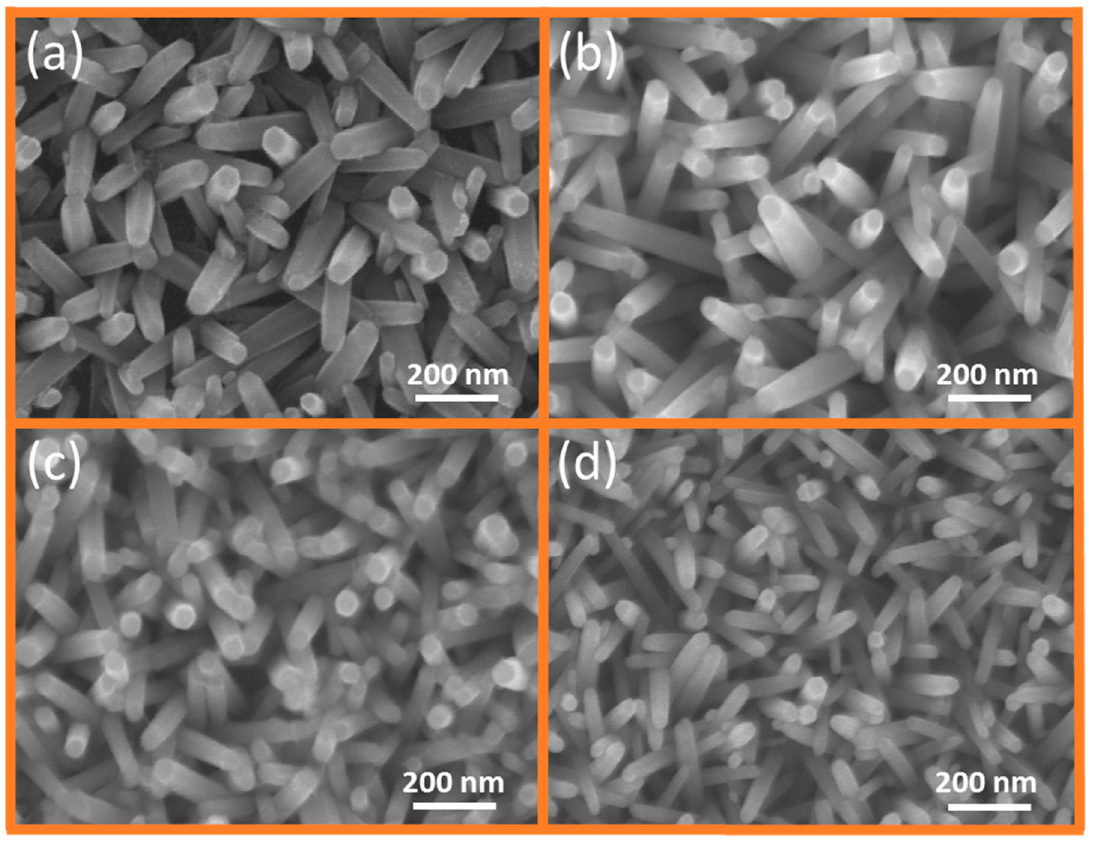
Figure 2. SEM images of: ( a ) UZRs; ( b ) 1% GZRs; ( c ) 2% GZRs; and ( d ) 5% GZRs.